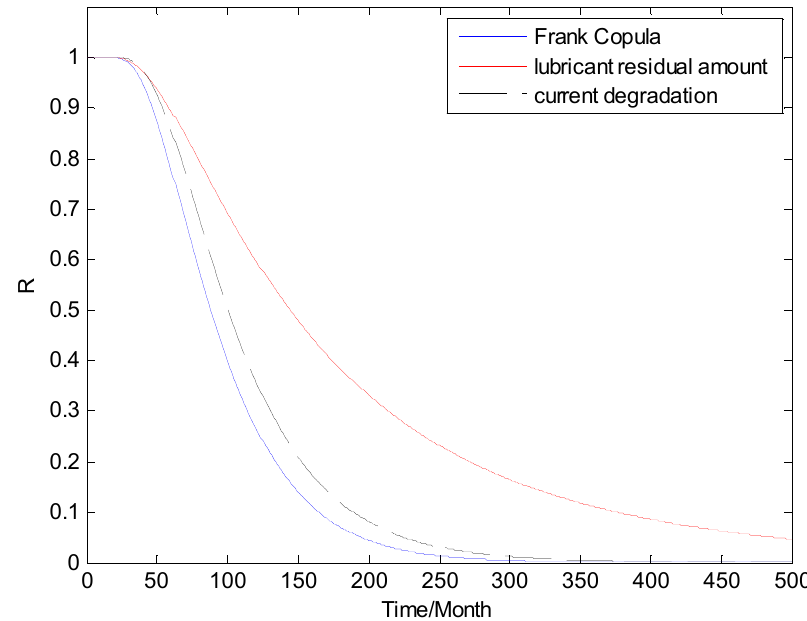
Figure 3. Momentum wheel reliability function curve based on frank copula function.